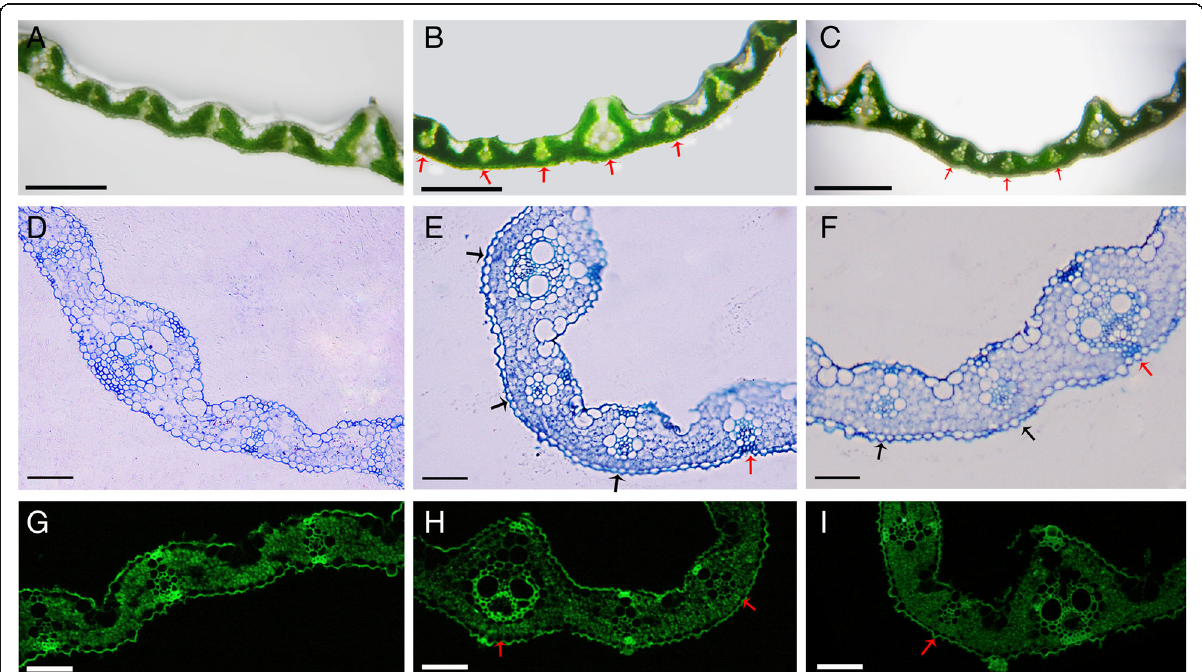
Fig. 6 Anatomical observation of wild-type and OE- AGO1b leaves. a - c Freehand cross-sections of 30-day-old seedling leaves (the fourth leaf of the seedling) of wild type ZH11 ( a ), OE- AGO1b line 25 ( b ) and line 365 ( c ). Red arrows indicate defective sclerenchymatous cells of the OE- AGO1b leaf. Scale bars = 250 μ m. d - f Semi-thin cross-sections of 30-day-old seedling leaves (the fourth leaf of the seedling) of ZH11 ( d ), OE- AGO1b line 25 ( e ) and line 365 ( f ). Black arrows and red arrow indicate defective and normal sclerenchymatous cells of the OE- AGO1b leaves respectively. Scale bars = 100 μ m. g - i Secondary cell wall autofluorescence of leaves from 30-day-old wild-type ( g ) and OE- AGO1b seedlings of line 25 ( h ) and line 365 ( i ). Red arrows indicate defective sclerenchymatous cells with weak autofluorescence on the abaxial side of the OE- AGO1b leaf. Scale bars = 50 μ